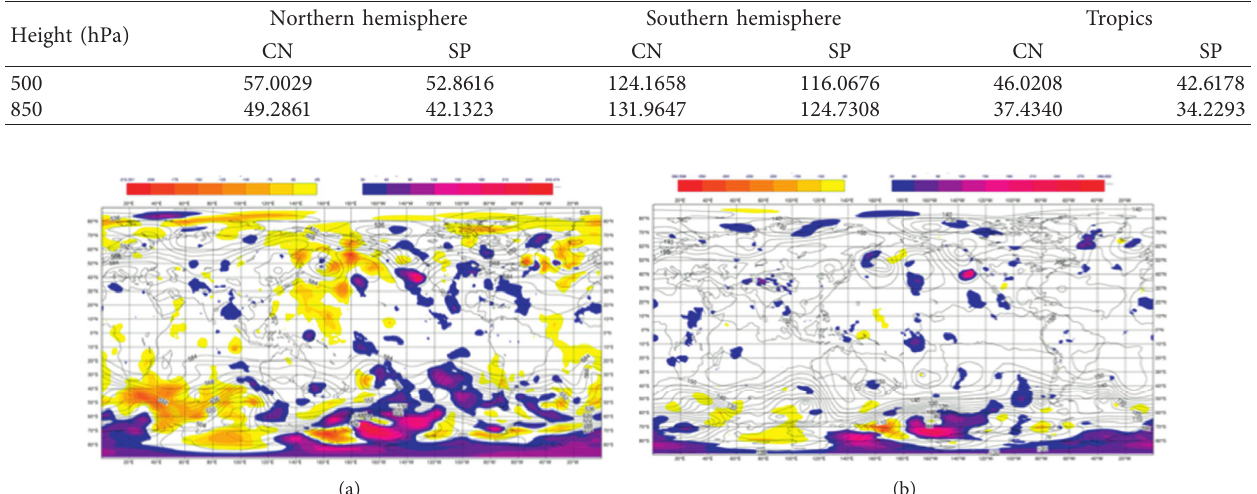
Figure 12: (a) The difference between SP and CN analysis at 500 hPa geopotential height. (b) is the same but at 850hPa.